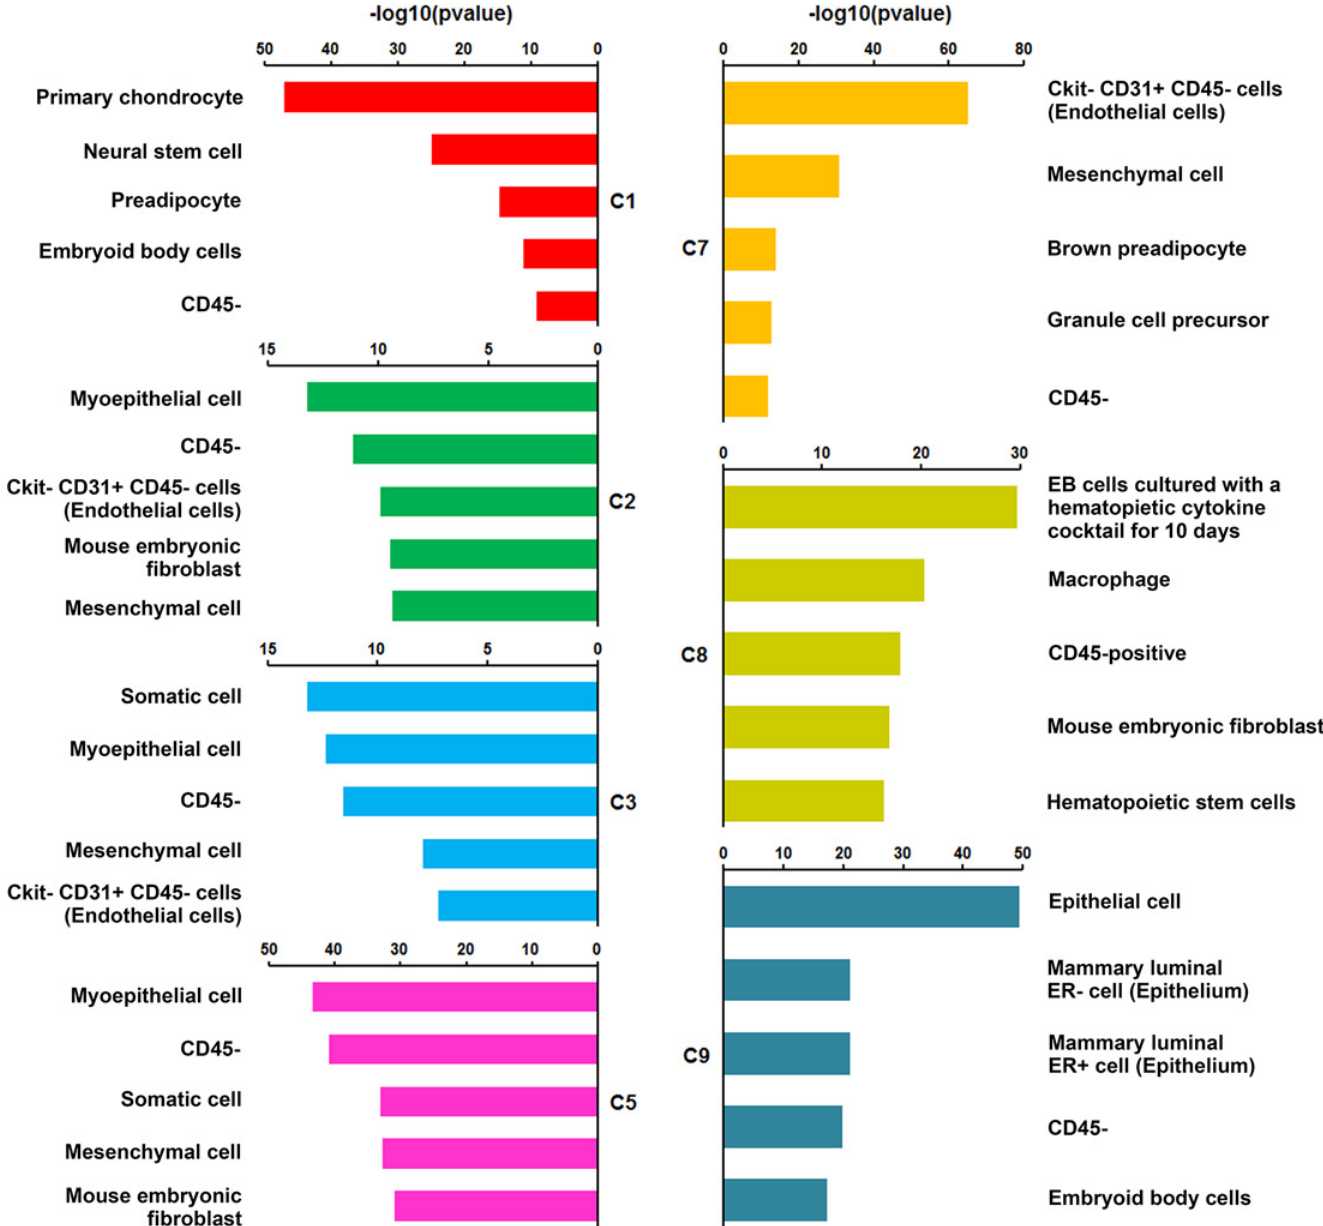
Fig 4. Prediction of Cell Types for Each Cluster using Cell Type Enrichment Analysis. Information on gene expression in certain cell types were downloaded from EBI Expression Atlas (http://www.ebi.ac.uk/gxa). Results were obtained using differentially expressed genes as the input gene lists. The lengths of the bars represent transformed p-value ( − log 10 ( p )) of highly enriched cell types for each cell cluster, where p is the p-value calculated by one-tailed Fisher ’ s exact test and represents the degree of a cell type enrichment in a given cell